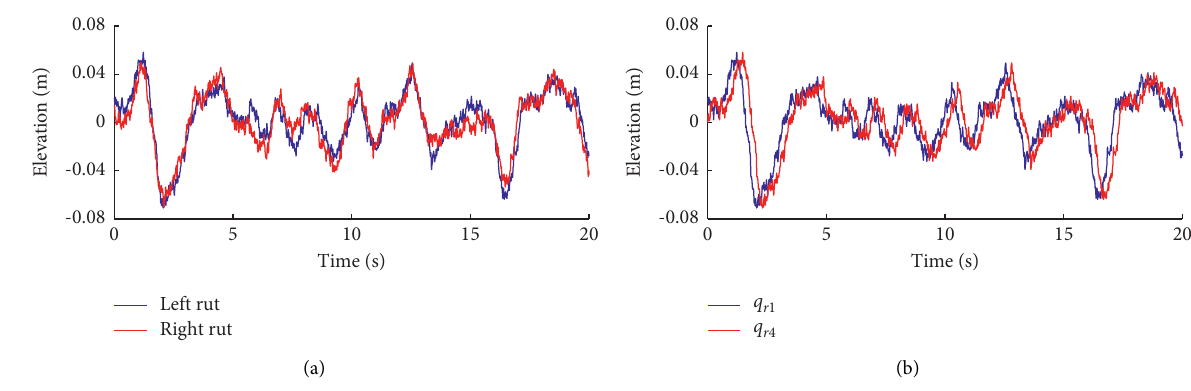
Figure 1: Roughness input on Gobi